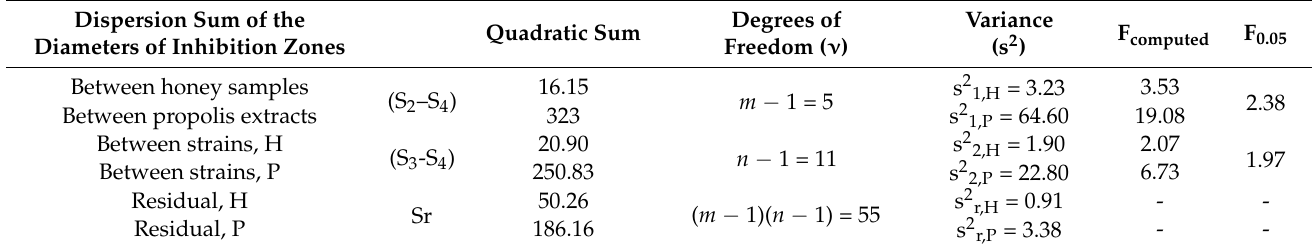
Table 12. Statistical bifactorial analysis of variance for samples from Alba County.